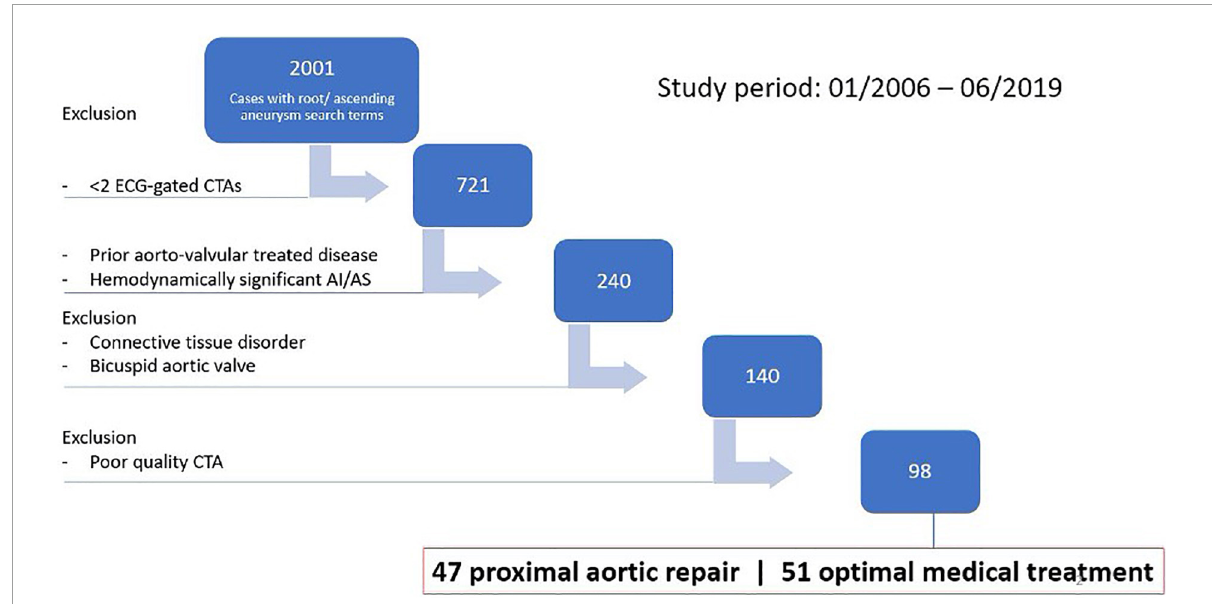
FIGURE1 Inclusion and exclusion chart.